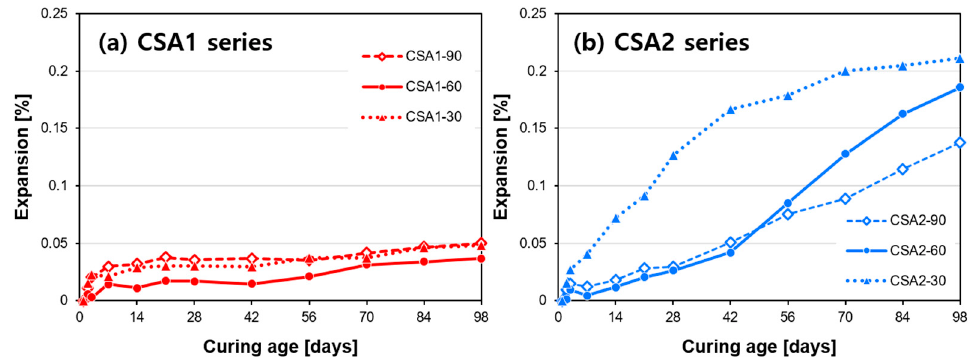
Figure 4. Expansion behaviors of ( a ) CSA1 and ( b ) CSA2 cement based mortars up to 98 days.